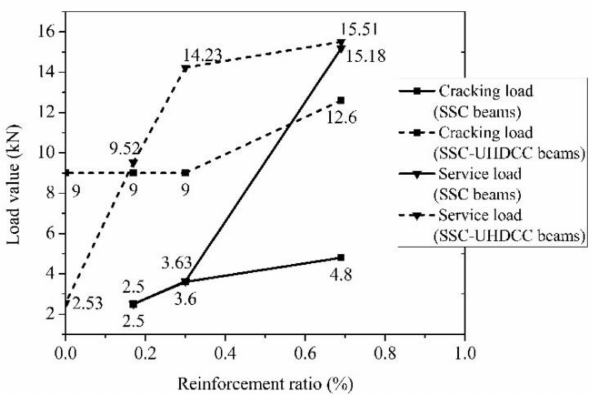
Figure 13. Cracking load and service load of